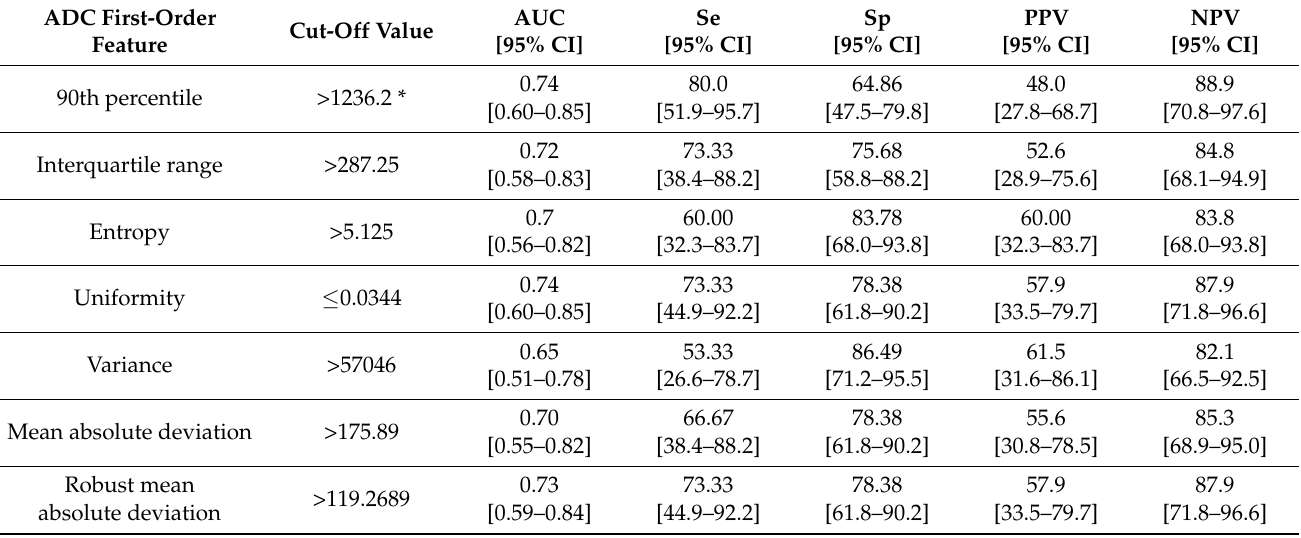
Table 5. Diagnostic performance of ADC first-order features for predicting metachronous